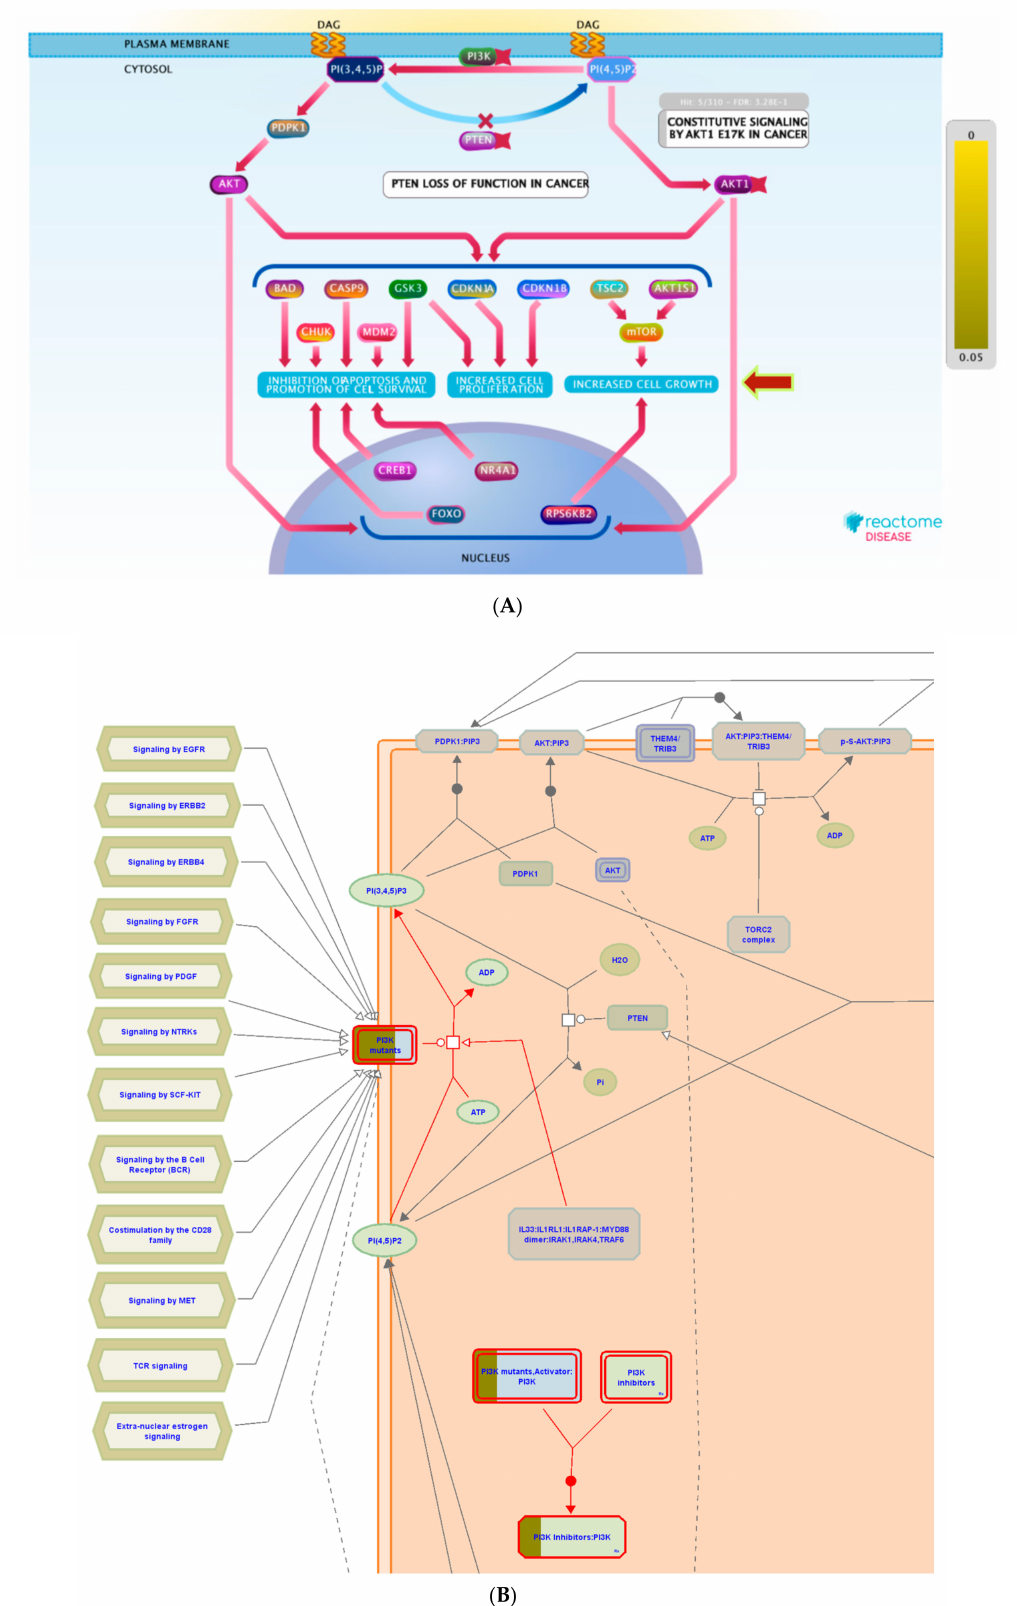
Figure 8. ( A ) Graphic representation of the diseases of signal transduction by growth factor receptors and ( B ) second messengers reactome pathway, influenced as a response to ST-1 in the human